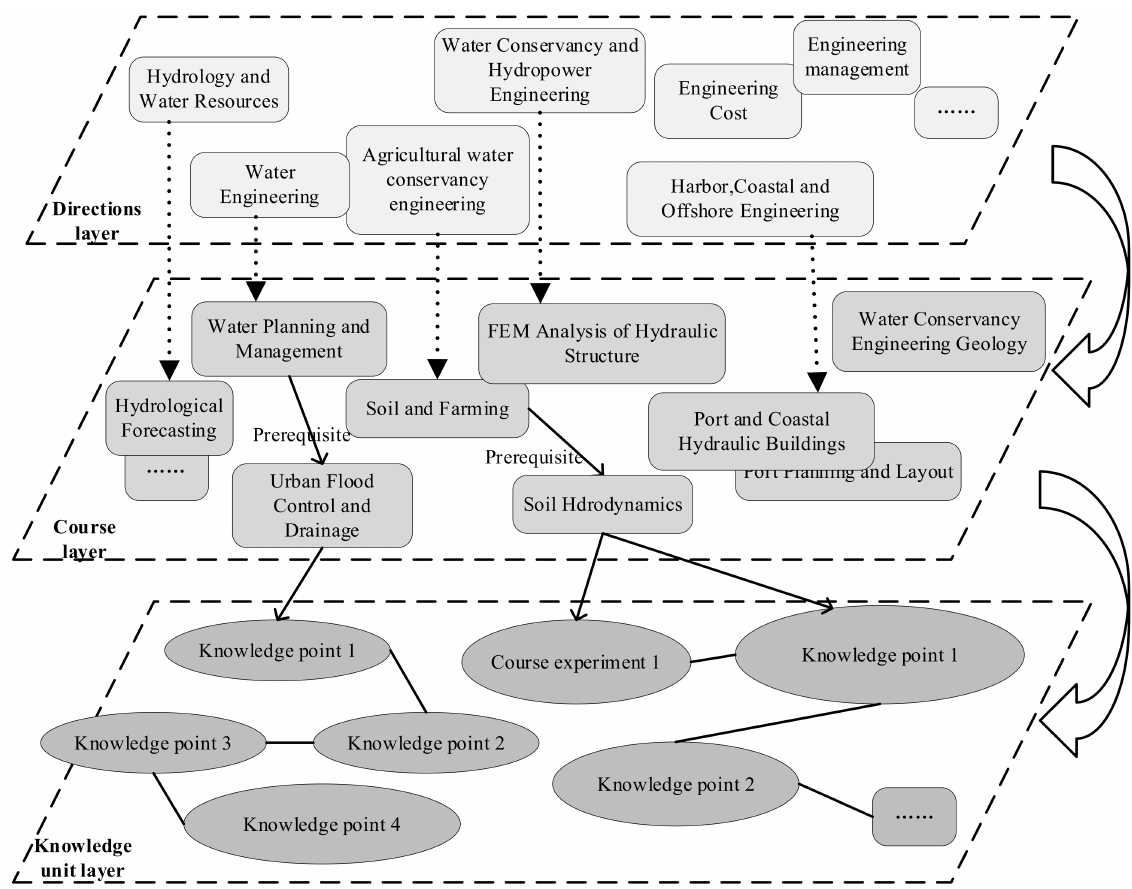
Figure 2. Three-layer Goal-oriented Water Conservancy Disciplines Knowledge Graph